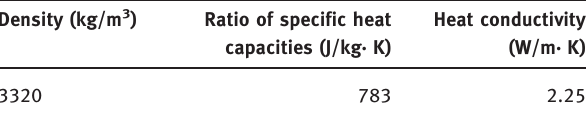
Table 1: Thermal properties of Cao.